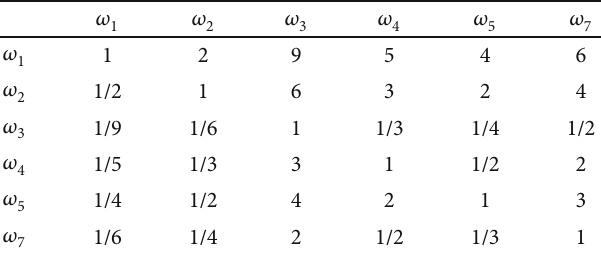
Table 2: Comprehensive list of weight values.